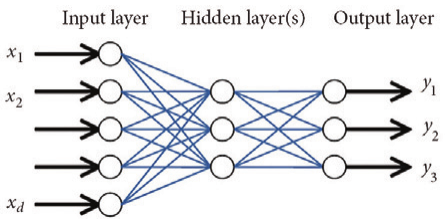
Fig. 1. Typical structure for the three layers of Back-Propagation Neural Network meta model